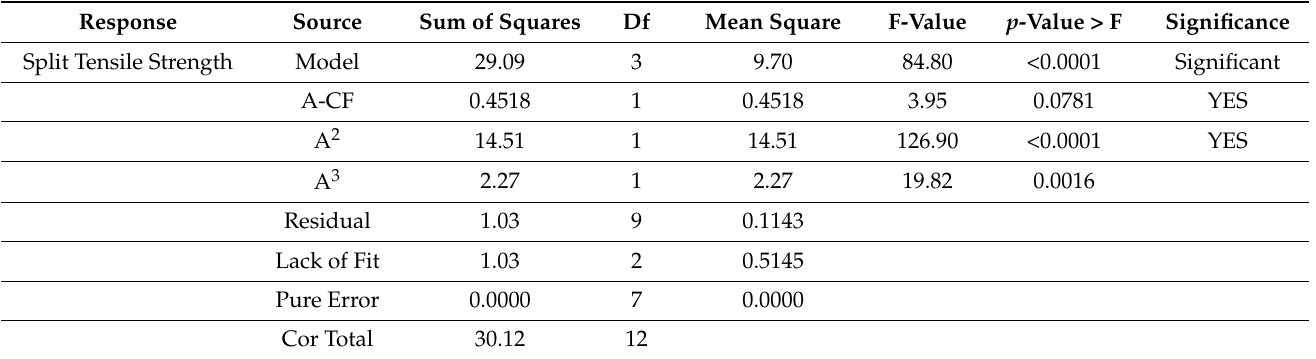
Table 7. ANOVA Results for the Variable Response 28-day Splitting Tensile Strength.